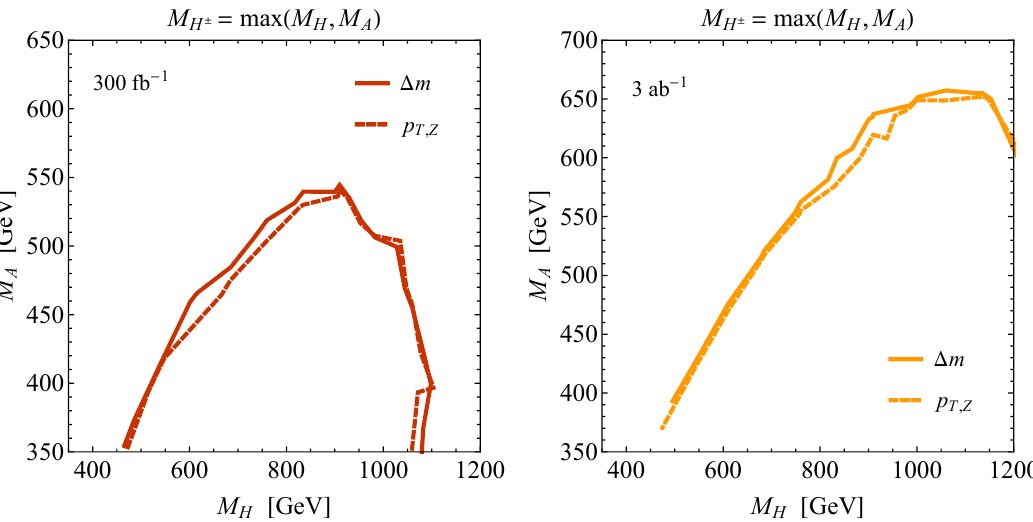
Figure 11 . Comparison of the performance of the (cid:1) m (solid contours) and p T;Z (dashed contours) shape (cid:12)t. The left (right) panel shows the 95% CL exclusions obtained using 300 fb (cid:0) 1 (3 ab (cid:0) 1 ) of p s = 14 TeV data. The used parameters resemble those employed in (cid:12)gure 9. See text for further